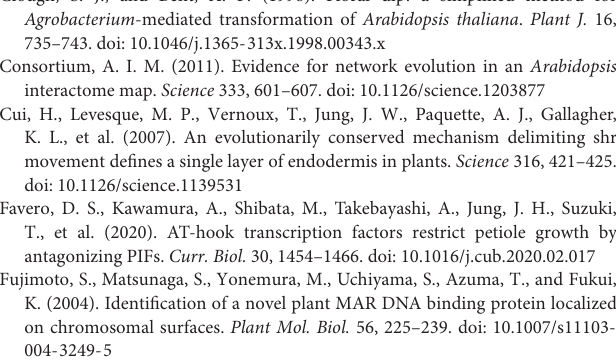
Supplementary Figure 1 | Expression patterns of AHL1, AHL2, AHL3, AHL4, AHL6, and AHL7 in representative cell types of Arabidopsis roots. Relative expression patterns of AHL1, AHL2, AHL3, AHL4, AHL6, and AHL7 in the cell-type-specific expression data. Expression values were row-normalized to visualize relative expression patterns along cell types. Supplementary Figure 2 | Comparison of expression domains and intercellular movements of AHL1 and AHL4 in the root apical meristem. (A–E) Transcriptional and translational GFP expressions of AHL1 and AHL4 . (A) Wild type non-transgenic root, (B) pAHL1:erGFP, (C) p AHL1:AHL1-GFP, (D) p AHL4:erGFP, and (E) p AHL4:AHL4-GFP. Scale bar 20 µ m. Supplementary Figure 3 | Interaction between AHL3 and four types of AHL1-AHL4 chimeric proteins. The result of a 3-AT assay of the interaction between AHL3 and AHL1-4 chimeric proteins is shown. Left column, a pair of interactors; upper row, a series of selection media. DBD (bait), DNA binding domain; AD (prey), Activation domain. Supplementary Figure 4 | Cell-type-specific molecular marker expression levels in four types of xylem organization: (A–C) Expressions of TMO5 (A) , ARR5 (B) , and AHP6 (C) of the ‘normal’ type. (D–F) Expressions of TMO5 (D) , ARR5 (E) , and AHP6 (F) of the ‘four xylem cell’ type. (G–I) Expressions of TMO5 (G) , ARR5 (H) , and AHP6 (I) of the ‘six xylem cell in a row’ type. (J–L) Expressions of TMO5 (J) , ARR5 (K) , and AHP6 (L) of the ‘extra-xylem’ type. Xylem phenotype categorization is identical to that in Figures 5A–D . Yellow arrowhead, xylem axis. Supplementary Table 1 | Xylem phenotype scoring of ahl4 introduced with four chimeric proteins under the SHR promoter and statistical analyse. Supplementary Table 2 | Xylem phenotype scoring of ahl4 introduced with four chimeric proteins under the AHL4 promoter and statistical analyses. Supplementary Table 3 | List of primers used in this